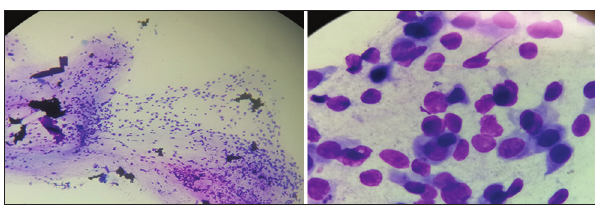
Figure-7: Spatula cytology sample-to the left 20× magnification, to the right 100×